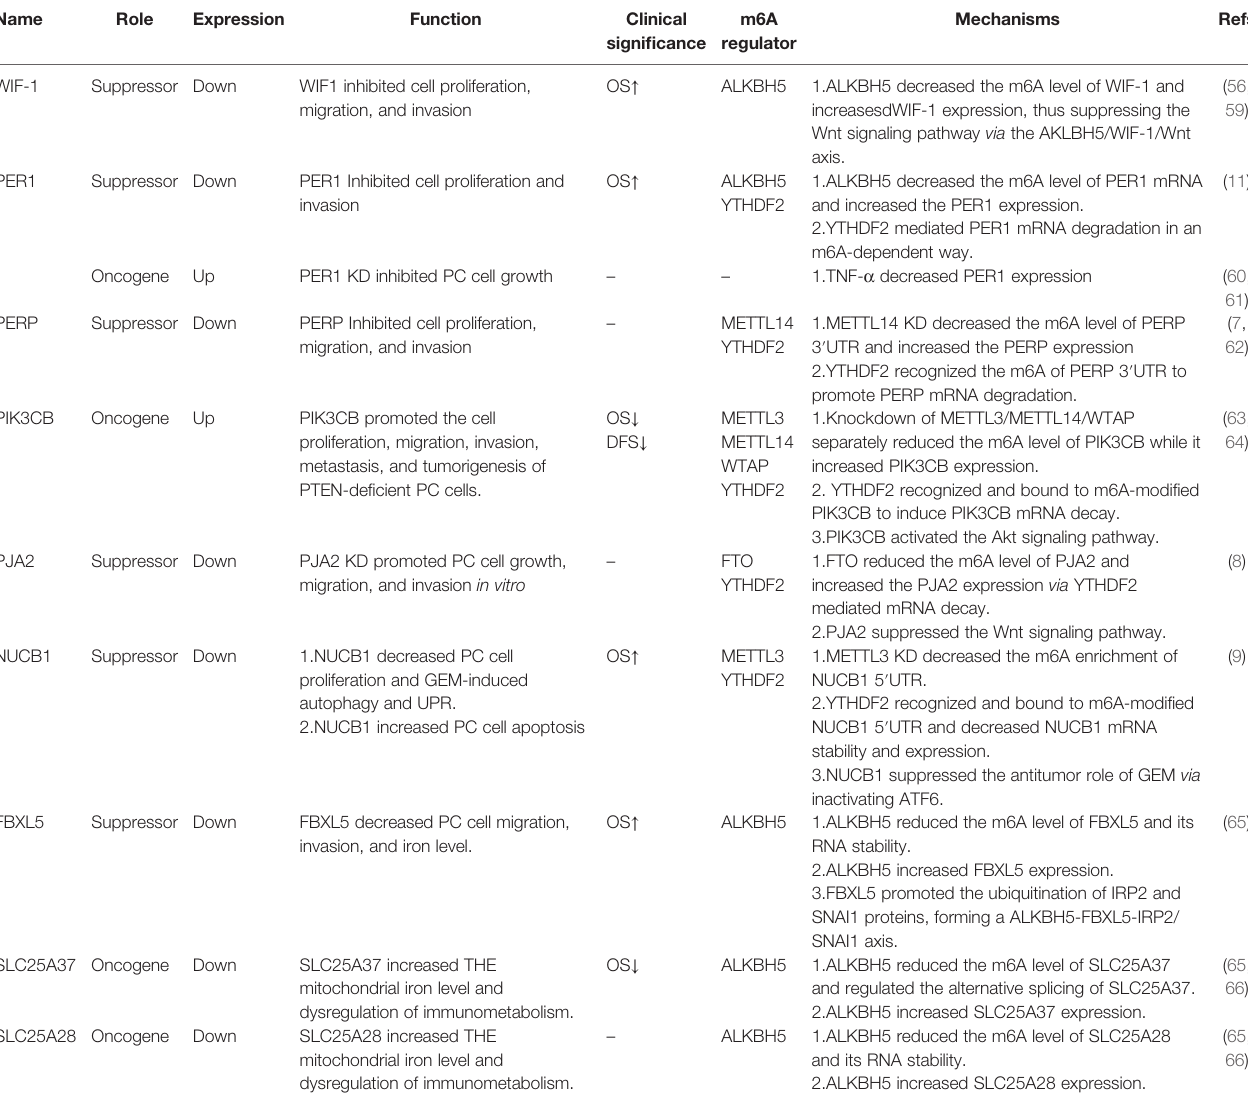
TABLE 1 | m6A modi fi cation of mRNAs in pancreatic